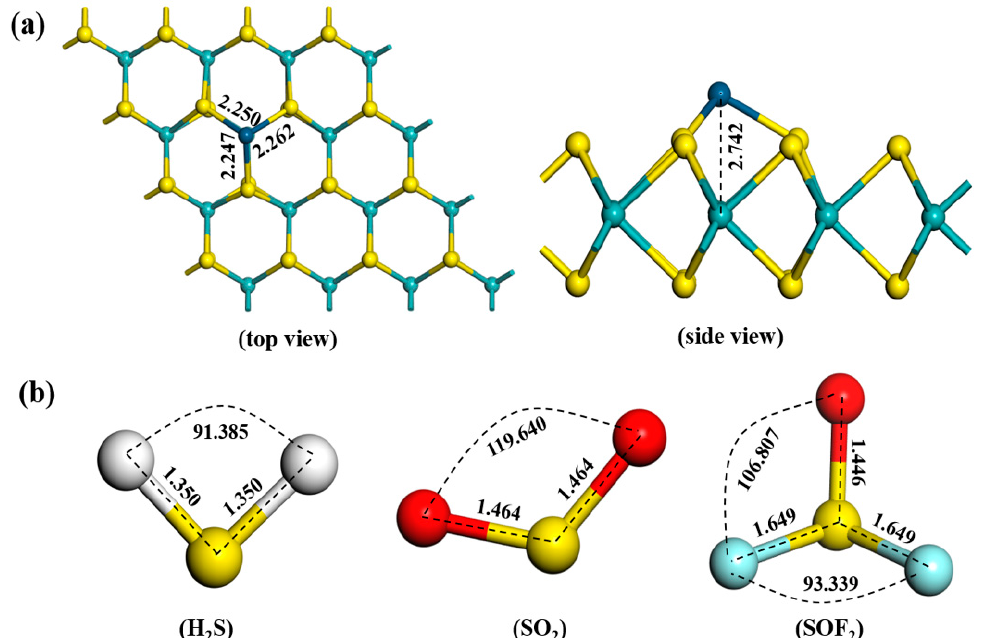
Figure 1. Structures of ( a ) Ir-modified MoS 2 and ( b ) gas molecules.